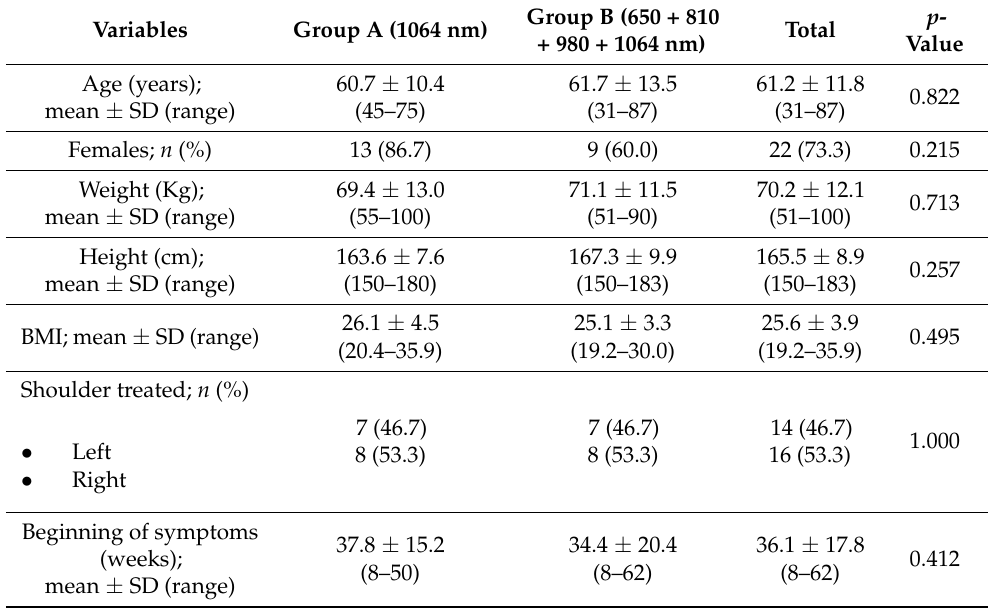
Table 1. Characteristics of the sample, by treatment.